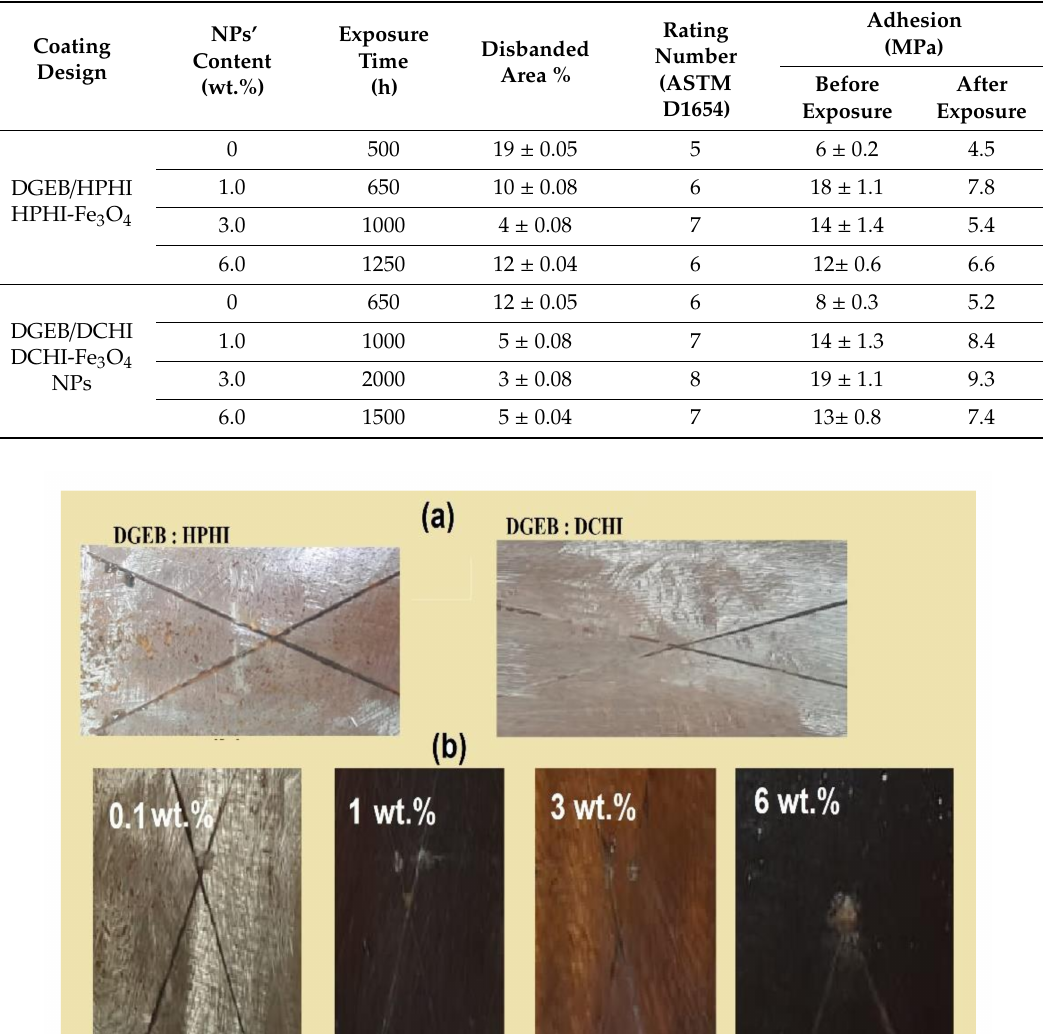
Table 6. Salt spray resistance of DGEB / DCHI and DGEB / HPHI coatings systems on the steel substrate in the absence or presence of HPHI-Fe 3 O 4 and DCHI-Fe 3 O 4 NPs after di ff erent exposure times.